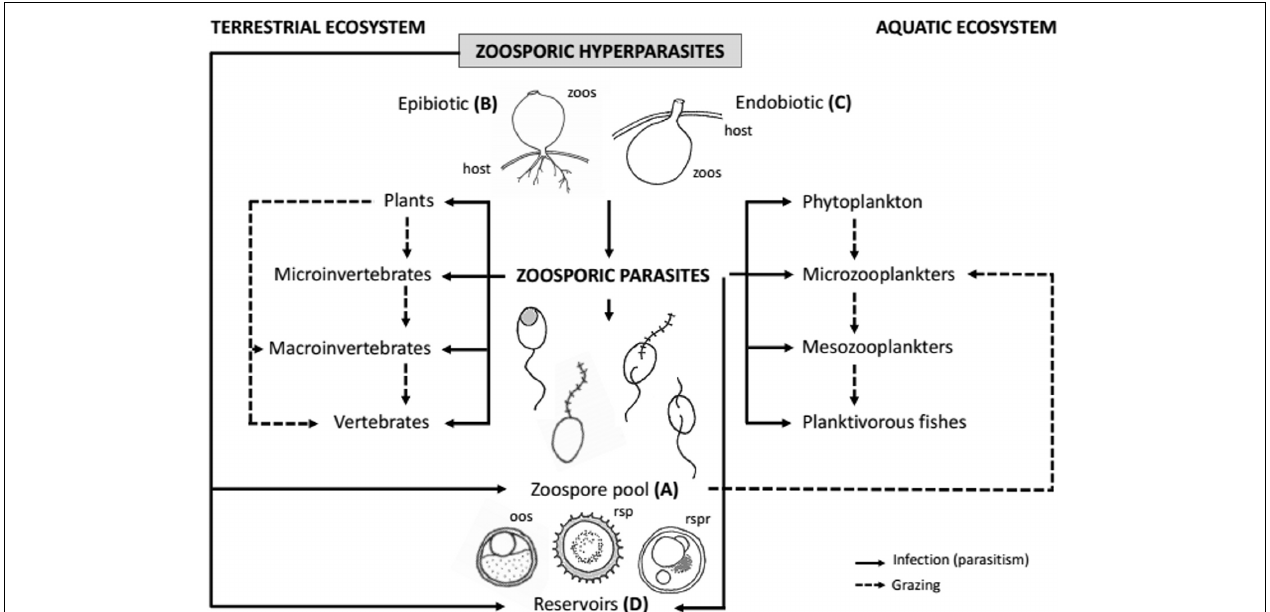
FIGURE 2 | Possible links of a hypothesized food web in which zoosporic parasites and hyperparasites are involved. In food webs zoosporic hyperparasites can either contribute the zoospore pool (Zoospore pool, A ) which is used as food source by grazers in terrestrial and acquatic ecosystems. At the same time epibiotic sporangia of hyperparasites (Epibiotic, B ) can serve as food source for larger grazers. The sporangia of epibiotic hyperparasites (Endobiotic, C ) are more difficult to access as food